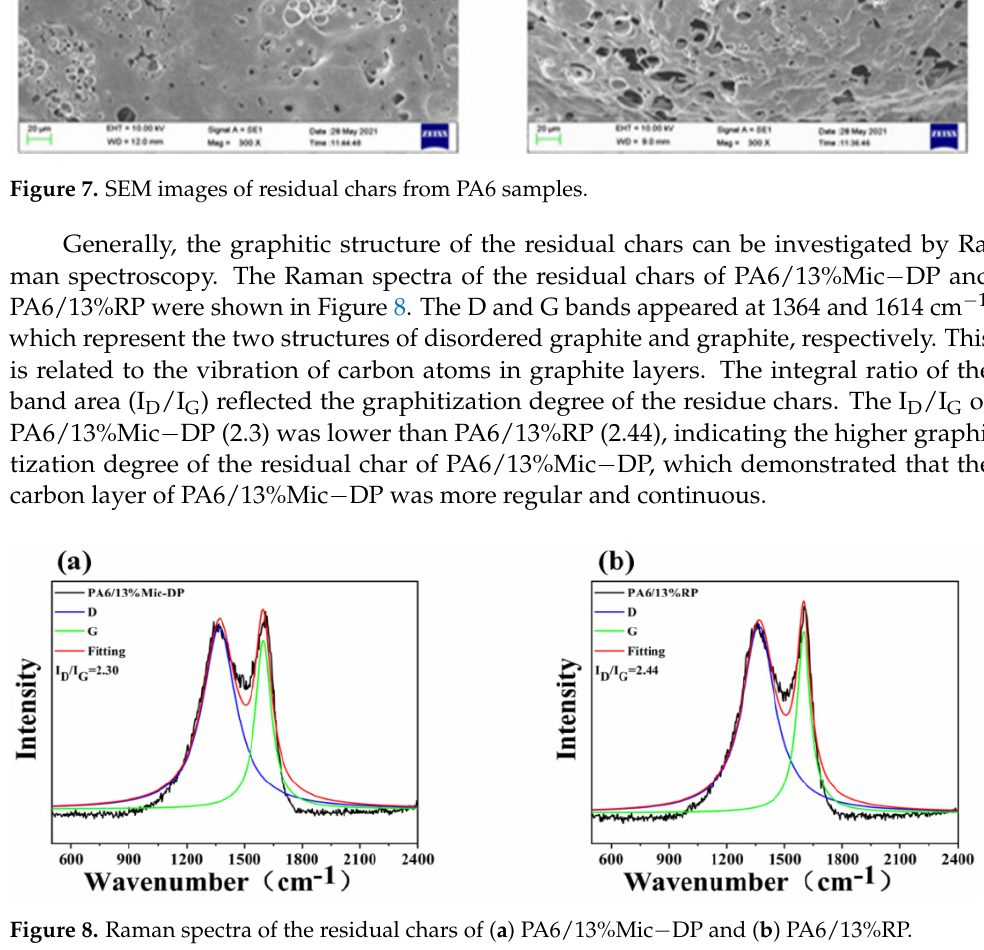
Figure 7. SEM images of residual chars from PA6 samples.